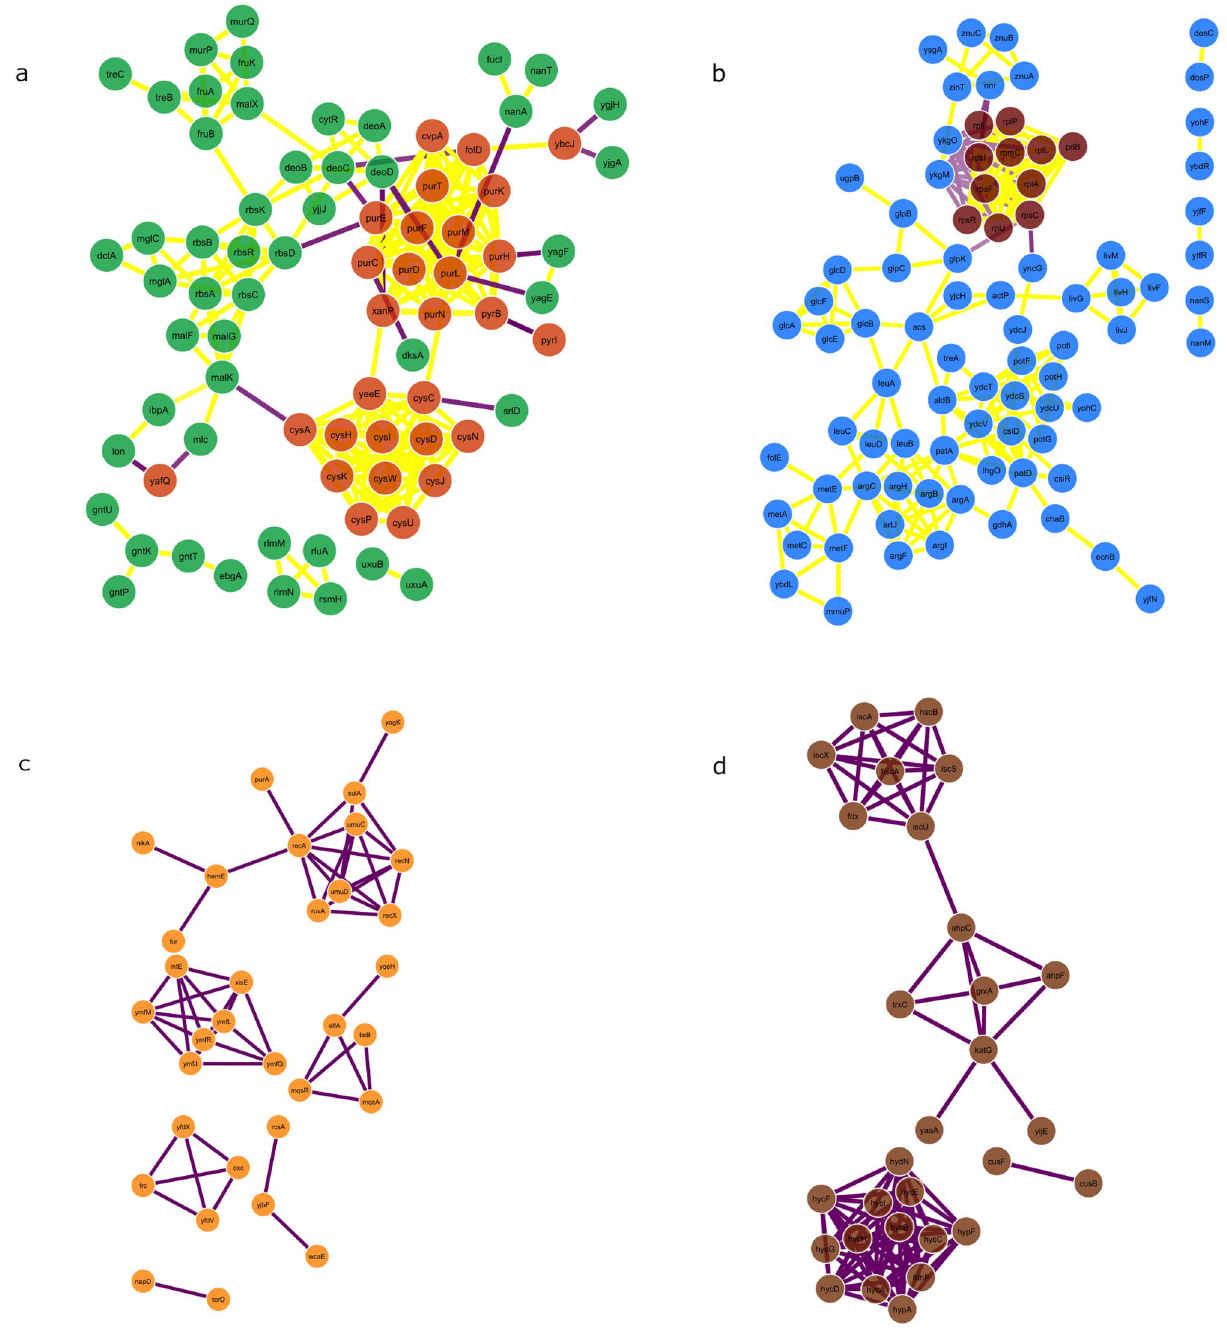
Figure 5. PPI networks. Protein–protein interactions of gene products for significant module-environment associations identified. Modules were subsetted based on their intramodular connectivity on a scale of 0 to 1. Subset of highly interconnected genes in LB ( a ), Poor M9 ( b ), Rich M9 with 0.3 µg/mL trimethoprim ( c ) and Rich M9—low oxygen growth ( d ). Due to the small number of PPIs for orange (trimethoprim) and saddle brown (low oxygen), these modules were not subsetted, Node colours represent module colours. Magenta and yellow edges show positive (both genes connected are either upregulated or downregulated) and negative (one gene is upregulated and the other is downregulated) correlation between genes,